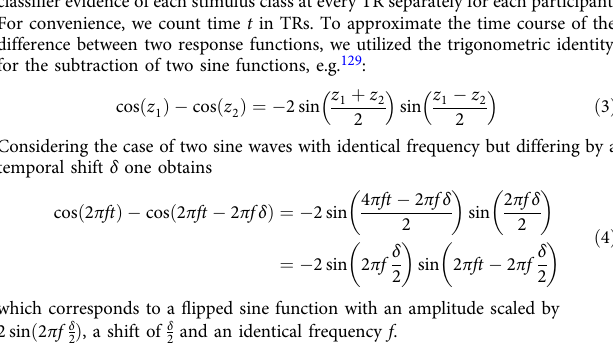
in Table 1. Model fi tting was performed using NLoptr , an R interface to the NLopt library for nonlinear optimization 130 employing the COBYLA (Constrained Optimization BY Linear Approximation) algorithm (version 1.2.2.1) 131,132 . The resulting parameters were then averaged across participants, yielding the mean parameters reported in the main text. To assess if the model fi tted the data reasonably, we inspected the fi ts of the sine-wave response function for each stimulus class and participant using individual parameters (Supplementary Fig. 4).